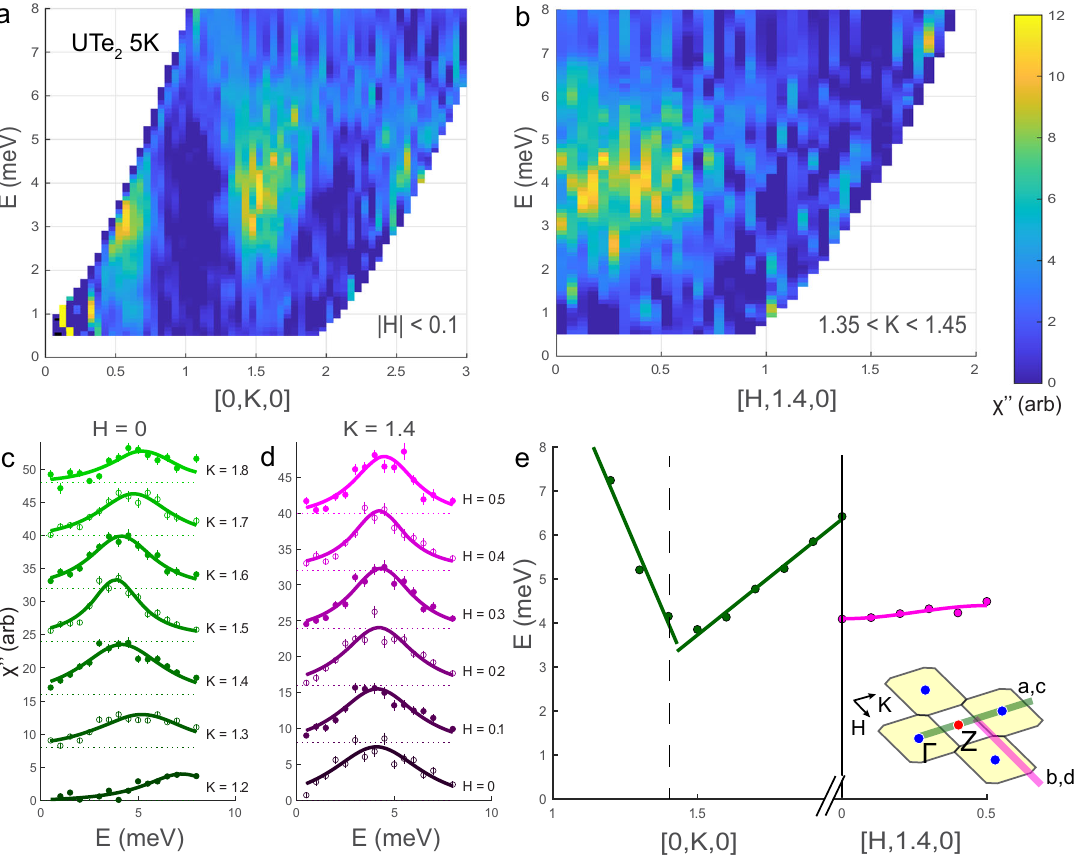
Fig. 2 The anisotropic Q -dependence of the magnetic susceptibility χ ″ ( Q , E ) in UTe 2 at 5 K along different slices of the [H,K,0] plane. a χ ″ ( Q , E ) as a function of K at constant H = 0. Along this direction, the dispersion is V-shaped and sharp, with energy minima at K = 0.6, 1.4 and 2.6, corresponding to the Brillouin zone boundaries. b χ ″ ( Q , E ) as a function of H at constant K = 1.4. The susceptibility is fl at in the H direction, extending to H = 0.5, the edge of the Brillouin zone. c , d Effective constant- Q scans show the E -dependence of χ ″ at selected values of K from ( a ) and H from ( b ). Curves are fi ts to Lorentzian lineshapes, which show that the width of the magnetic excitations is of order the peak energy. Whereas the lineshapes are rather dependent of K , there is relatively little H -dependence until the excitation disappears at the edge of the Brillouin zone. These fi ts are used to calculate the magnetic dispersion in ( e ) along these two directions. A clear anistropy appears about the BZ edge (dashed line). The inset shows a Q map of the data slices. Error bars correspond to an uncertainty of one standard